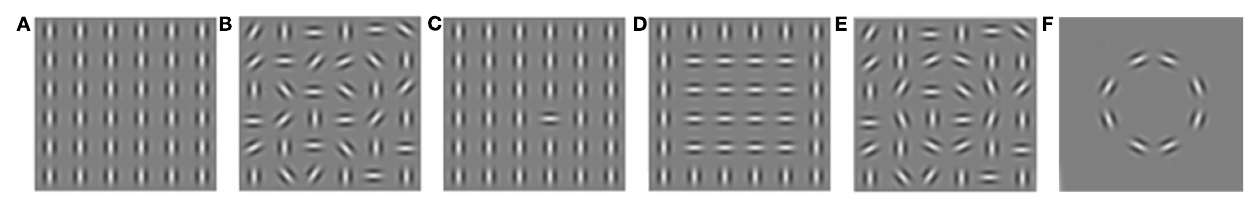
FIGURE 5 | Examples of stimuli used in different orientation-processing tasks. (A) Homogeneous. (B) Randomly oriented. (C) Single line. (D) Texture. (E) Contour with high background noise levels. (F) Contour with low background noise